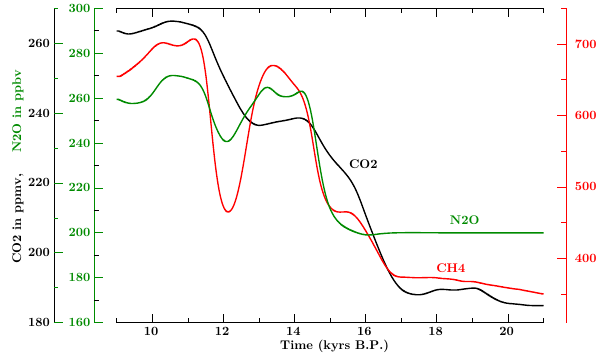
Fig. 1. Greenhouse gas evolution throughout the last deglacia- tion from air measurments on ice-core from both Greenland and Antarctica. CO 2 is taken from Neftel et al. (1988); Staffelbach et al. (1991); Inderm¨uhle et al. (1999); Petit et al. (1999); Monnin et al. (2004), CH 4 from Blunier and Brook (Science); D¨allenbach et al. (2000); Blunier et al. (1995); Chappellaz et al. (1993); Brook et al. (2000); Blunier et al. (1998); Spahni et al. (2005) and N 2 O from Flueckiger et al. (1999); Spahni et al. (2005). All series are on the EPICA EDC3 timescales and have been smoothed and interpolated on a yearly basis using a cubic spline interpolation scheme for easier use with the